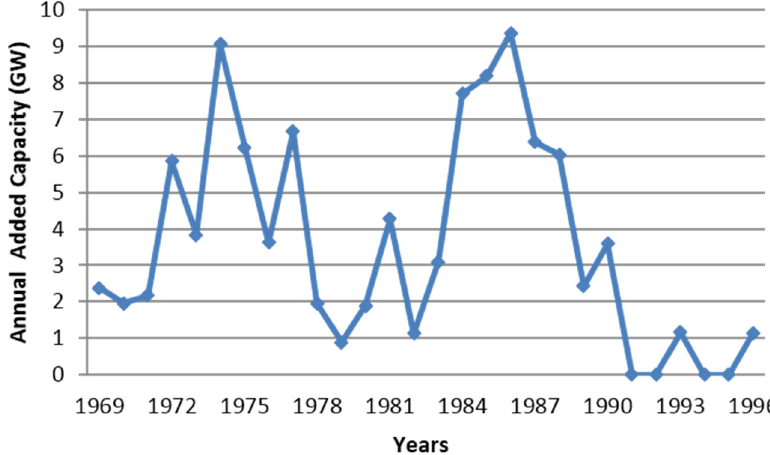
Figure 3. Historical annual addition to nuclear capacity in the